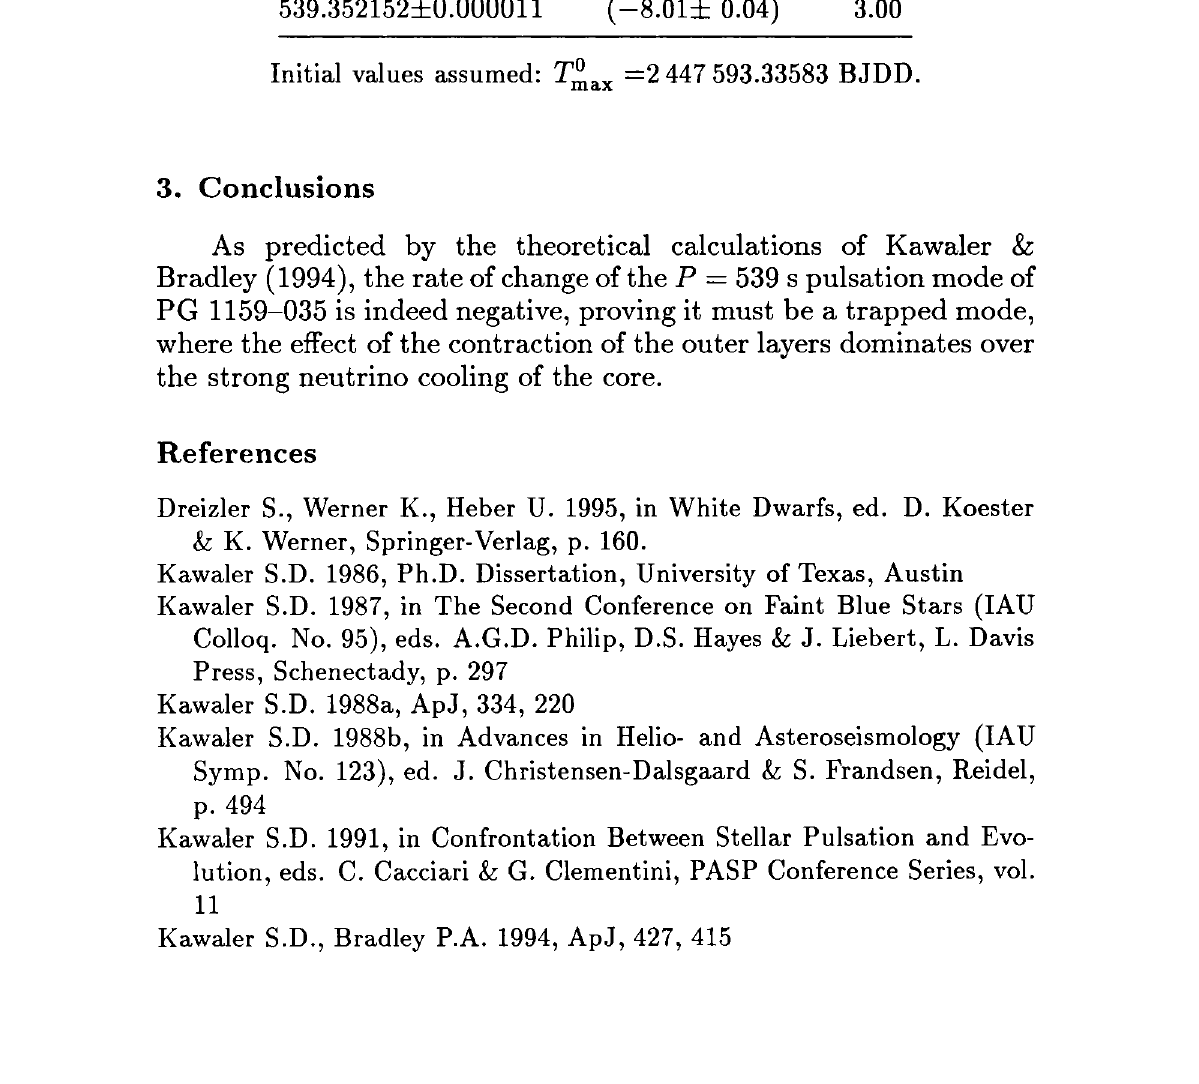
Table 2. List of the solutions for the (O-C') P Pa (s) ( x l O - 11 s/s)